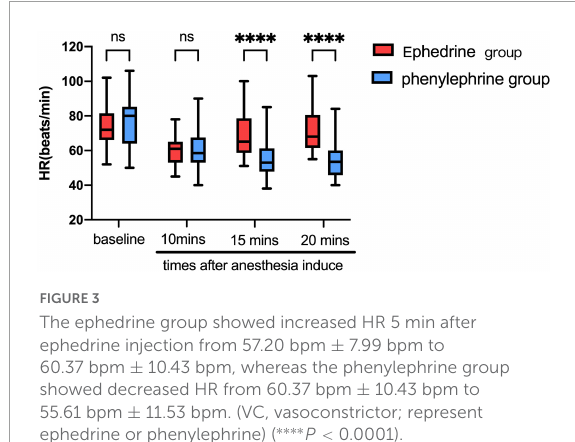
at baseline to 71.16 mmHg ± 10.51 mmHg ( P < 0.01), the HR decreased from 60.37 bpm ± 10.43 bpm to